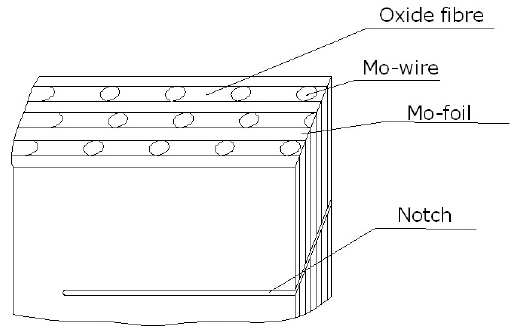
Figure 4. Schematic of a specimen with the notch.